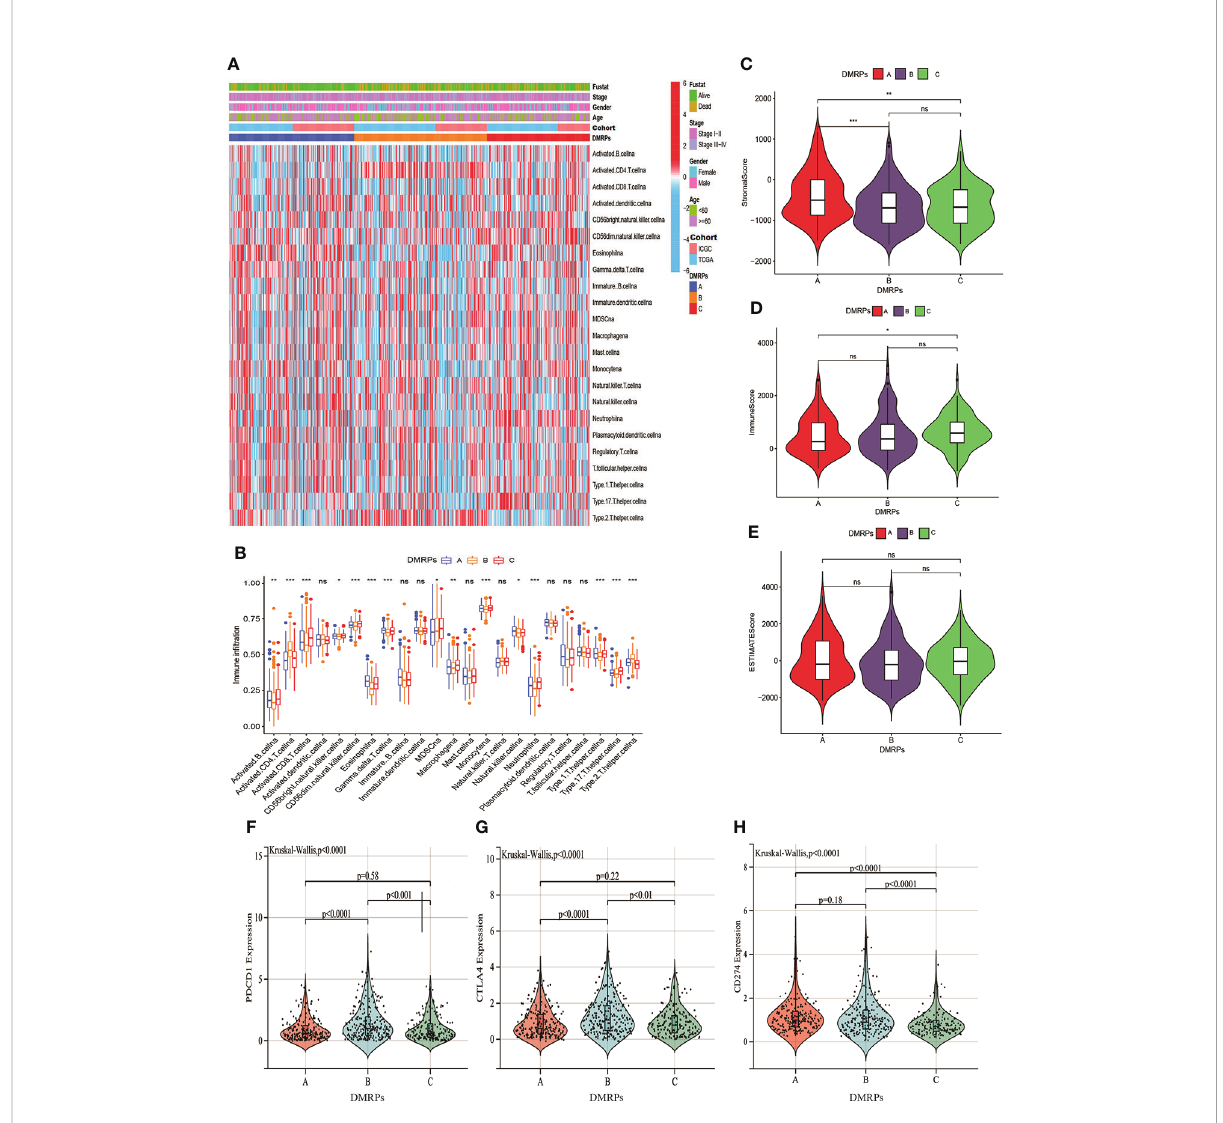
FIGURE 4 Characteristics of the TME immune cells in fi ltration in distinct DNA methylation regulators related modi fi cation patterns. (A) The heatmap of immune cell in fi ltration in three patterns. (B) The distribution of immune cells among three patterns. (C – E) The differences of TME score (stromal score, immune score and estimate score) among three patterns. (F – H) The expression levels of three important immune checkpoint in the three DMRPs. DMRPs: DNA methylation regulators related modi fi cation patterns; TME: tumor microenvironment. * P < 0.05, ** P < 0.01, *** P < 0.001, **** P < 0.0001. ns, no signi fi